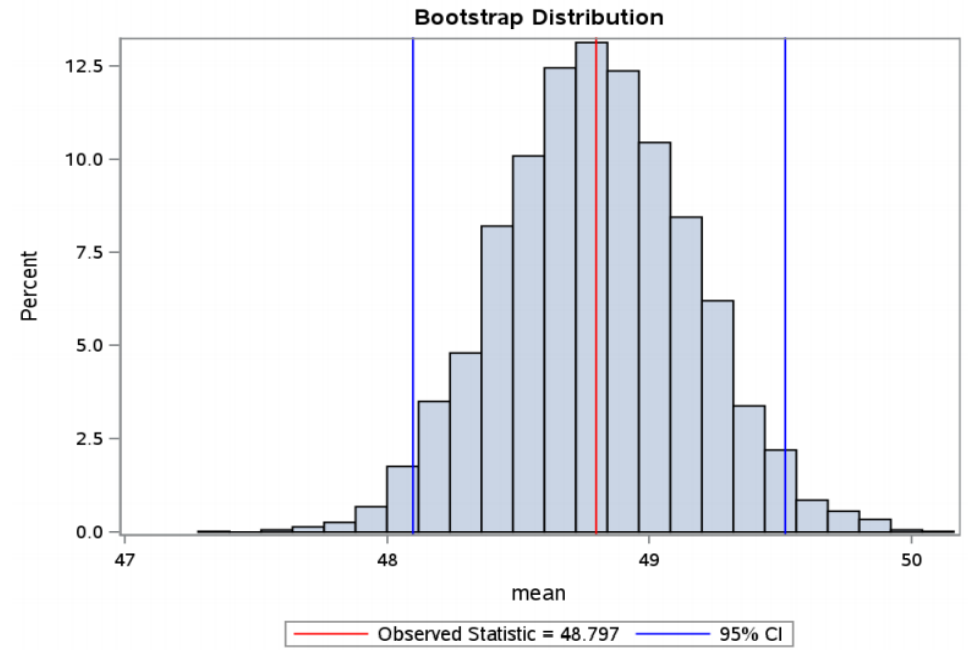
Figure 5. t5—bootstrap distribution—distribution according to the time of reaching the 5-cell embryo stage in the group of embryos with FHB (in hpi—hours post insemination). Bootstrap distribution t5: